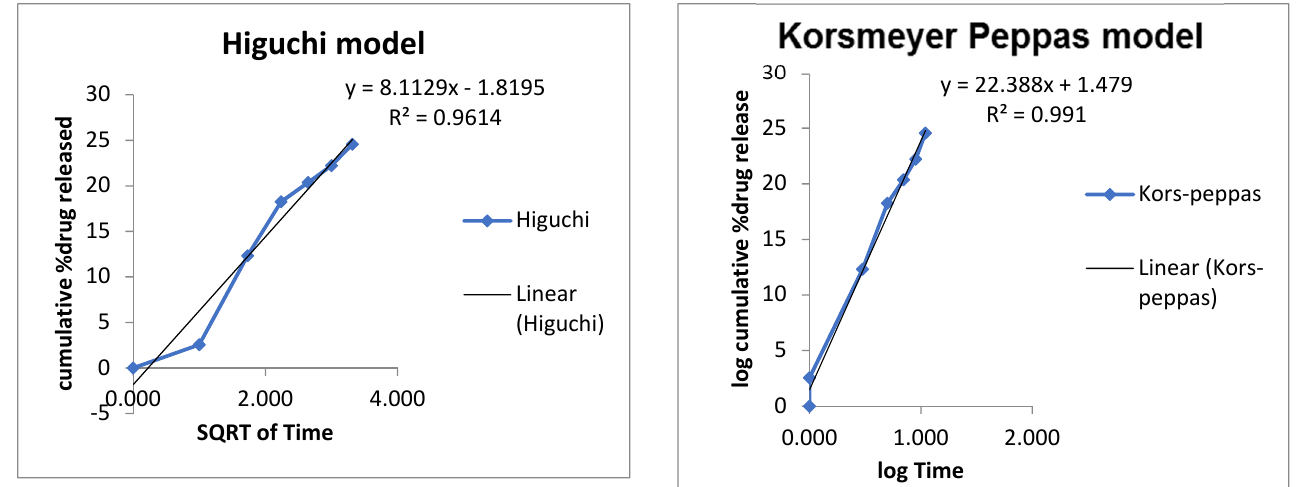
Figure 10. Release mechanism of cinnamon oil from optimized nanoemulsion formulation.